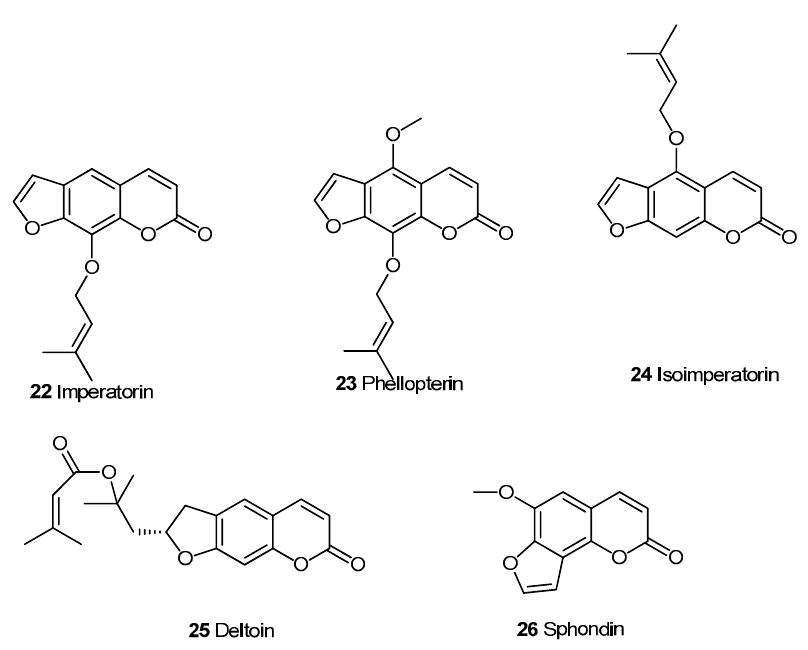
Figure 2. Naturally occurring furocoumarins.